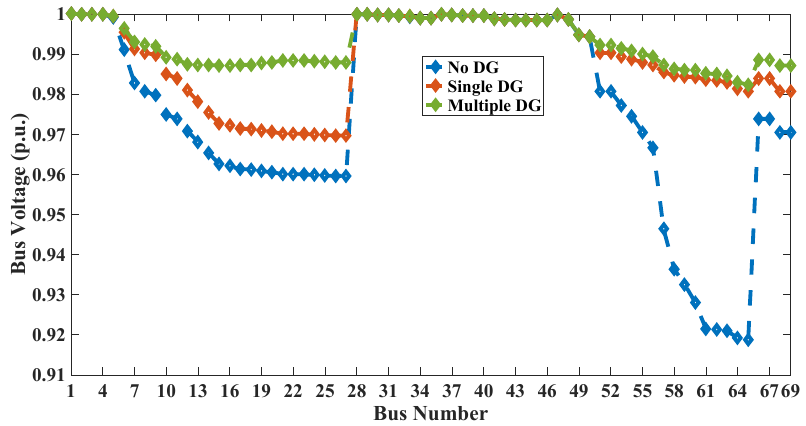
Figure 9. Variation of bus voltage before and after placement of DG for Industrial Load.